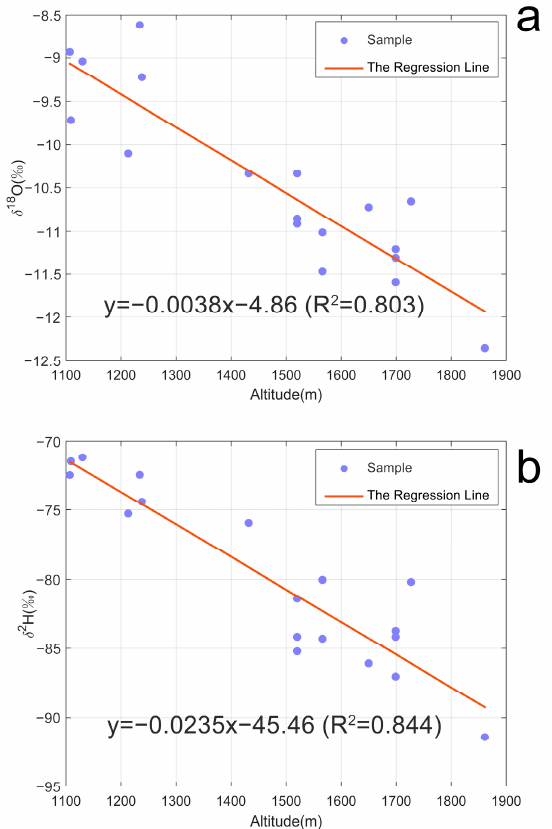
Figure 4. Plot of altitude vs. δ 2 H ( a ) and altitude vs. δ 18 O ( b ) for Tengchong hydrothermal